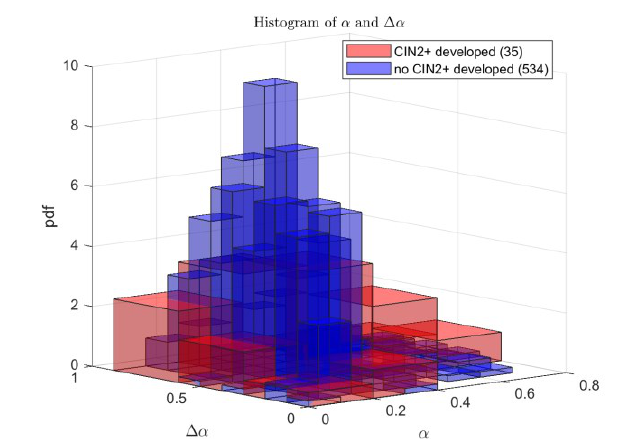
Fig.4: 2-D histogram of α̅ - ∆α data points from two groups